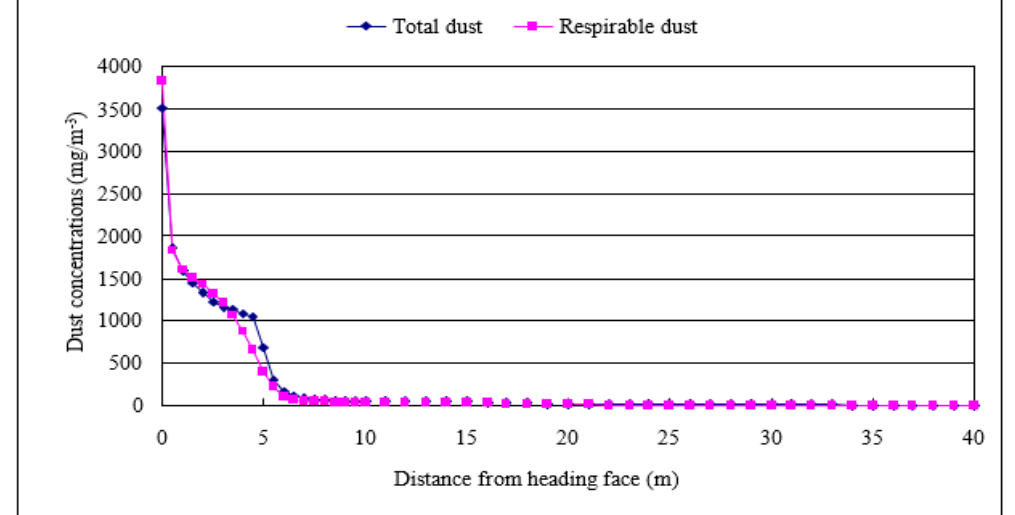
Figure 17. Face averaged dust concentration under vortex ventilation system.